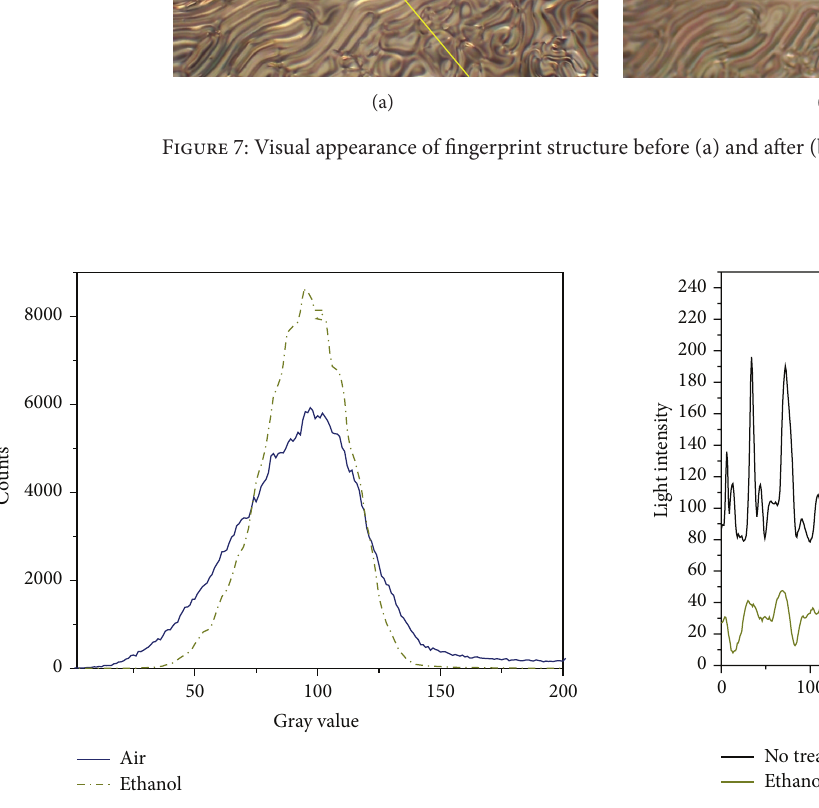
Figure 8: Brightness analysis of the whole chiral fingerprint struc- ture before and after injection of ethanol.